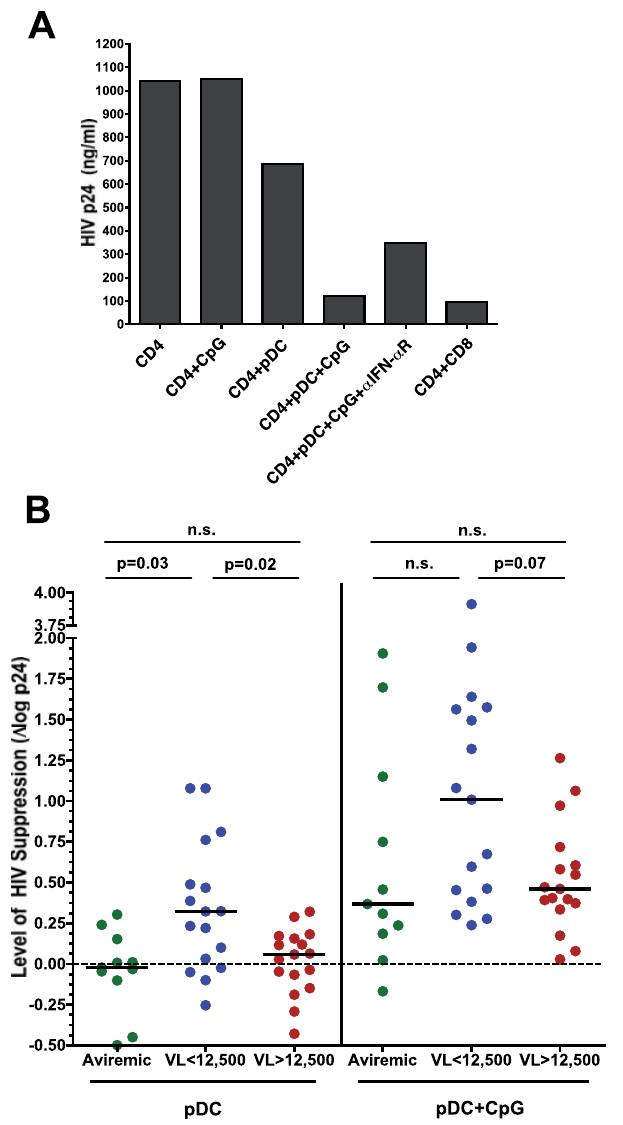
Figure 2. pDC-mediated suppression of HIV replication in autologous CD4 + T cells. pDCs were purified from HIV-infected individuals and plated overnight at 5 6 10 4 cells/well with or without 1 m g/ml CpG ODN 2216. For targets, autologous PBMCs were stimulated overnight with anti-CD3 and IL-2. On day 0, CD4 + T cells were purified and plated at 1.2 6 10 6 cells/well alone or with 5 6 10 4 stimulated or unstimulated pDCs, or with 1.2 6 10 5 purified autologous CD8 + T cells. Neutralizing antibody against IFN- a receptor was added at 5 m g/ml to some wells. Culture supernatants were collected at days 3, 5, and 7 and assayed for HIV p24 by ELISA. All data shown are from day 7. A) A representative example of data from a viremic patient. CpG ODN 2216 had no effect on CD4 + T cells alone, and the degree of viral suppression by activated pDCs was comparable to that by CD8 + T cells. B) Effect of pDCs on HIV replication in autologous CD4 + T cells. The degree of HIV suppression by pDCs was expressed as the difference of log HIV p24 production between the culture containing CD4 + T cells alone and the co-culture of CD4 + T cells and pDCs ( D log p24=log HIV p24[CD4 cells alone]-log HIV p24[CD4 + pDC]). Data are shown for unstimulated pDCs (left panel) and CpG-stimulated pDCs (right panel). Horizontal lines represent median values. n.s., not significant.